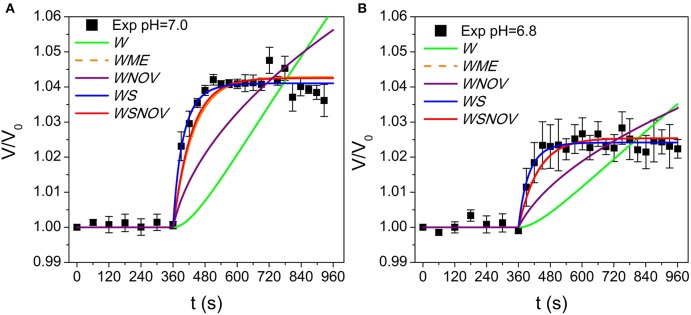
Model simulations of vacuole volume dynamics fitted to experimental data at pH 7.0 and 6.8. (A) shows pH 7.0 and (B) shows pH 6.8. Simulations obtained with the W model and the WNOV model cannot reproduce the experimental record. The other three models (WME, WS, and WSNOV) fit close to experimental data, and are practically not differentiable by visual inspection. Simulations obtained with published data with other pH conditions are shown in Figure S2. The parameter values are shown in Table S4 and the fitting analysis is shown in Tables S2, S3.